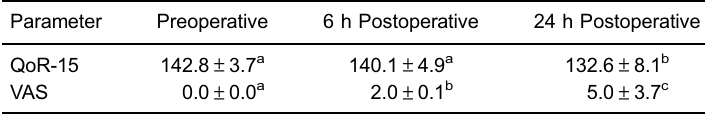
Table 4. Comparison of preoperative and postoperative Quality of Recovery-15 (QoR-15) and Visual Analog Scale (VAS) scores.